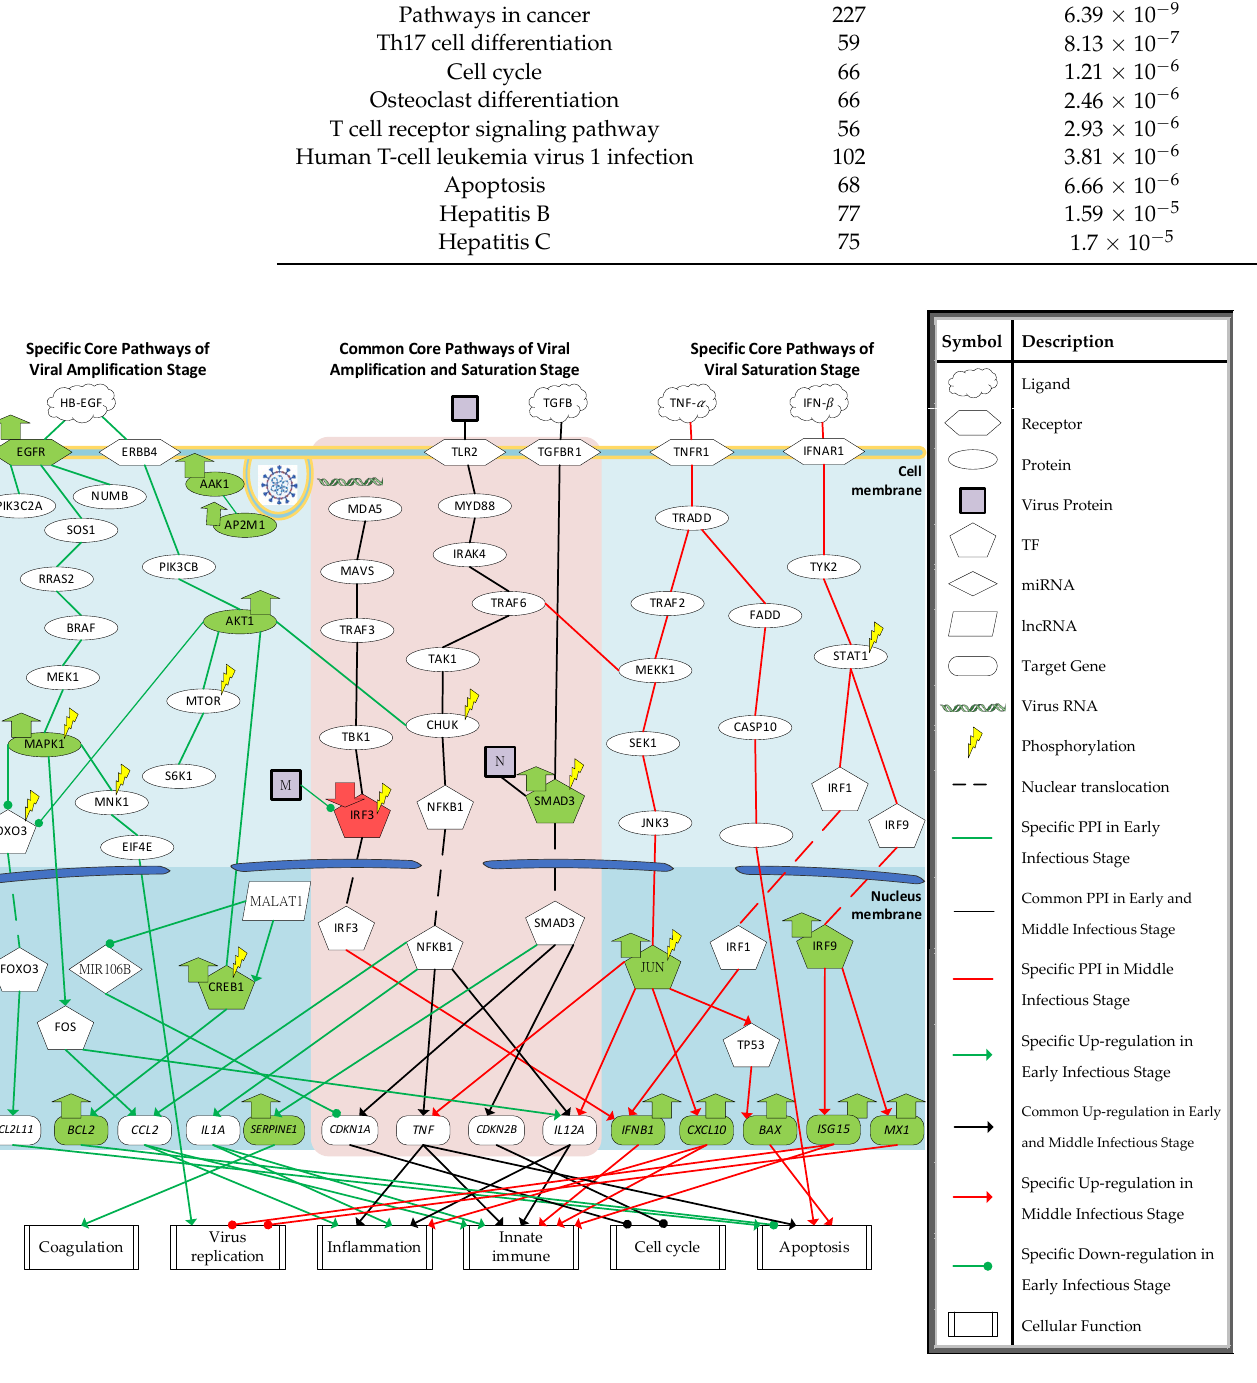
Figure 3. The core HPI signaling pathways and their downstream abnormal cellular functions of SARS-CoV-2 infection in (i) amplification stage (left-hand side), (ii) common between amplification and saturation infectious stages (red background in the middle of the figure), and (iii) saturation infectious stage (right-hand side). The green nodes represent the high expression of protein/gene. The red nodes represent the low expression of protein/gene.